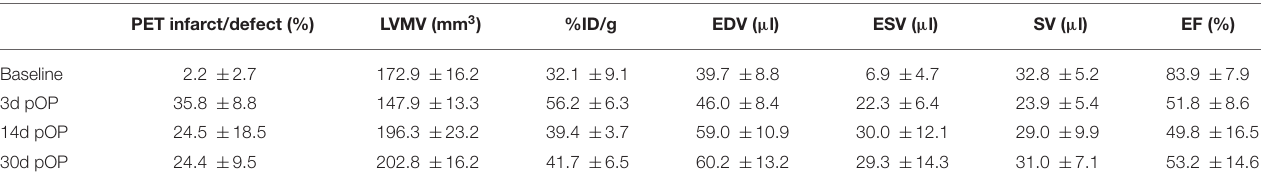
Values indicate Mean ± SD. Defect, LVMV, left ventricular metabolic volume; %ID/g, percentage of the injected dose per gram; EDV, end-diastolic volume; ESV, end-systolic volume; SV, stroke volume; EF, ejection